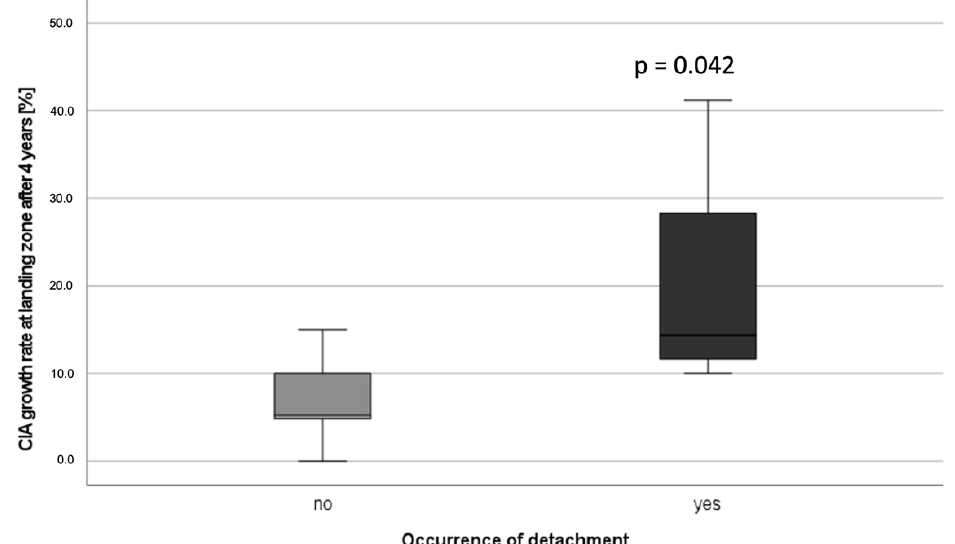
Figure 5. Common iliac artery growth rate at the landing zone for patients without detachment vs. patients with detachment four years after EVAR.